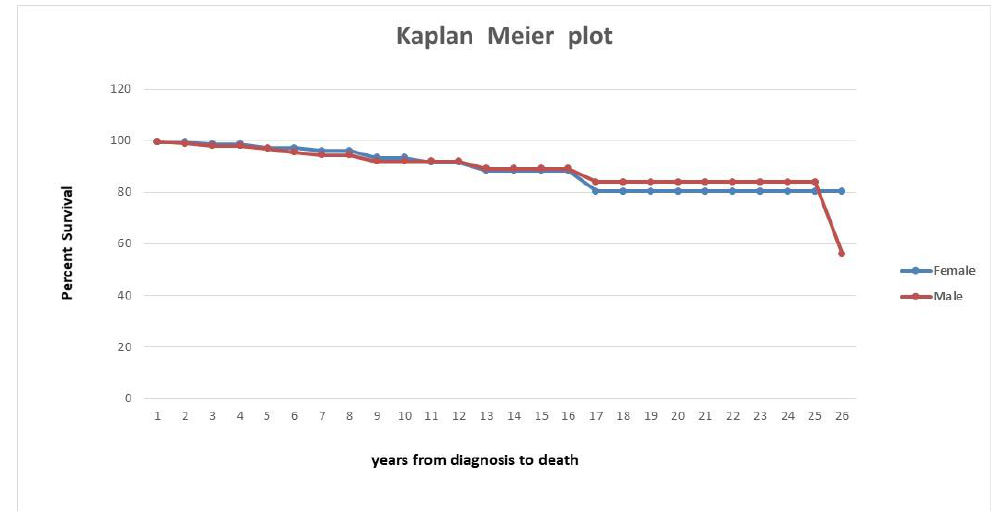
Figure 2. Survival of patients with PSC from the time of diagnosis stratified by sex (n = 485).